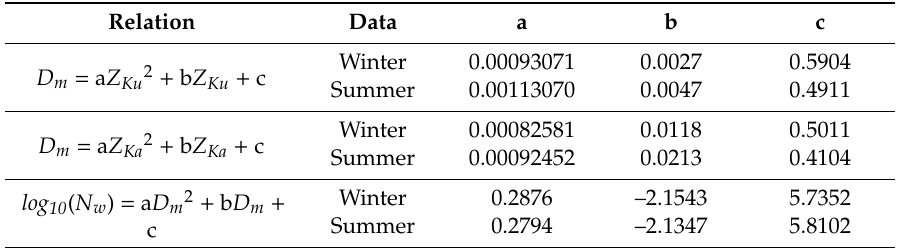
Table 3. Second-degree polynomial relationships of D m – Z Ku , D m – Z Ka and log 10 ( N w )– D m derived in two seasons.